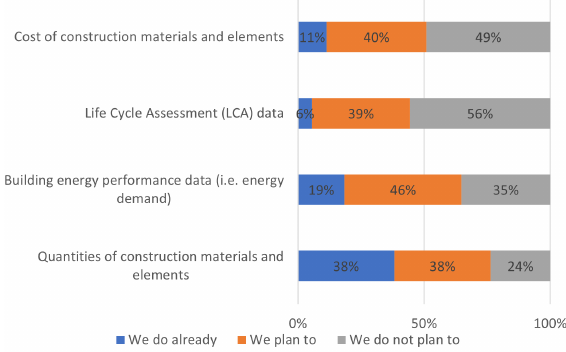
Figure 12. Responses to the question: Do you use BIM model’s capability to integrate information on the following aspects? (based on 55